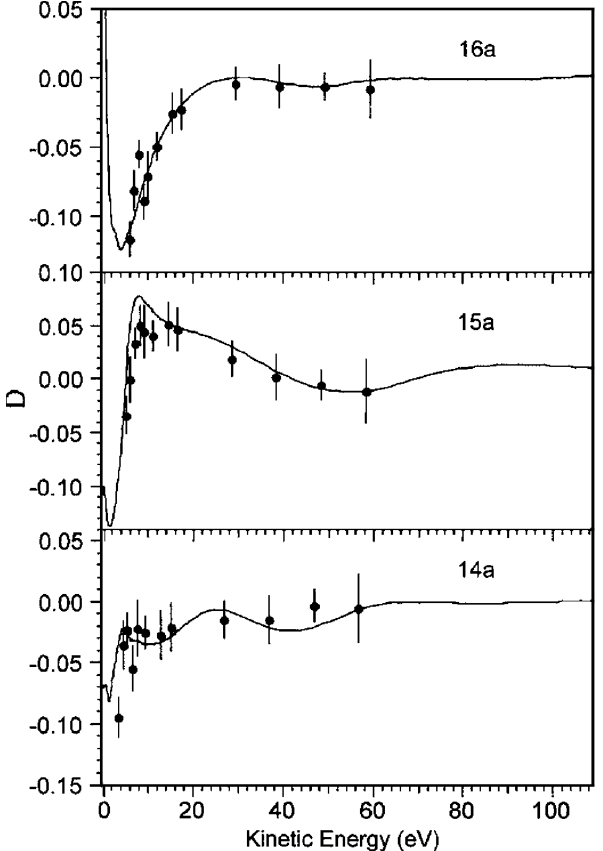
Figure 1. Dichroic PECD parameter β 1 (here D) relative to the three outermost bands of methyloxirane. Experimental points and DFT theoretical simulation. Reproduced from ref [12] with the permission of AIP Publishing.